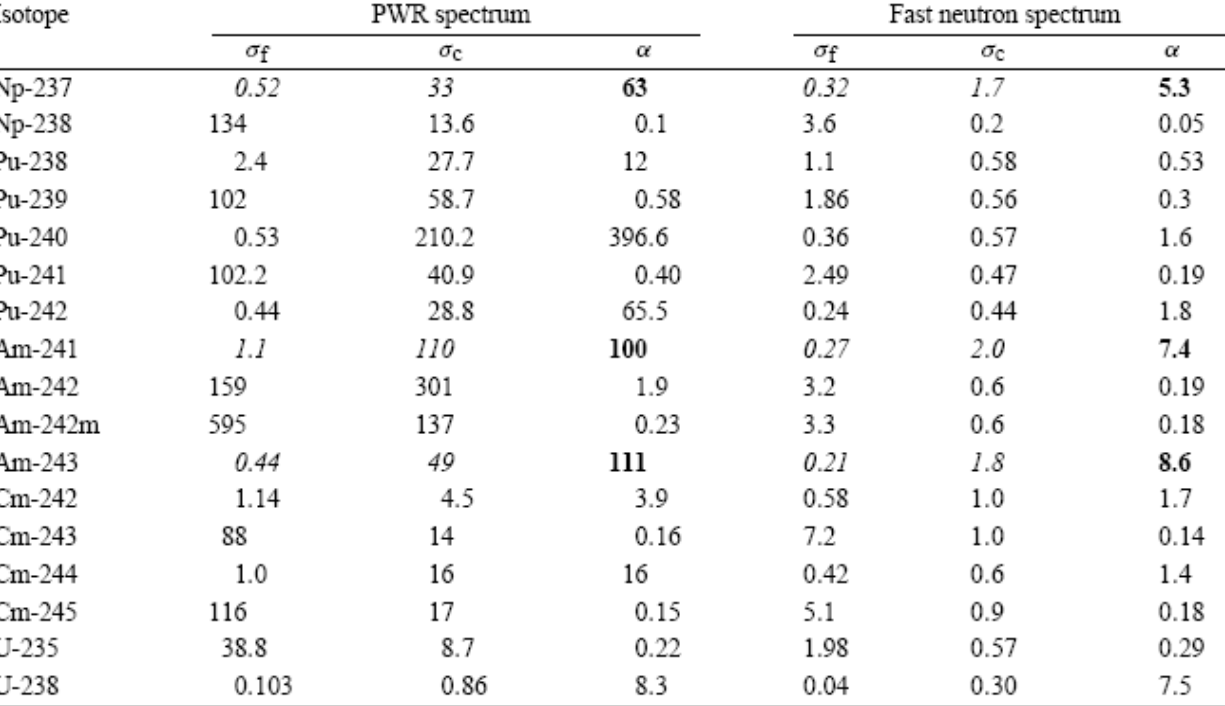
Table 2. Fission (  ) and caption (  ) cross-sections and their ratios  =  /  for a range f c c f of isotopes, and in two neutron energy ranges. The smaller  , the higher the probability for neutrons to cause fission. U-235 neutron caption is more likely to lead to fission for slow neutrons (PWR spectrum), whilst for Pu-239 this is the case for fast neutrons. Another important characteristic (not listed here) is the relative importance of the absorption cross- section of non-fissile isotopes such as U-238. © 2002 Elsevier, reproduced with permission from